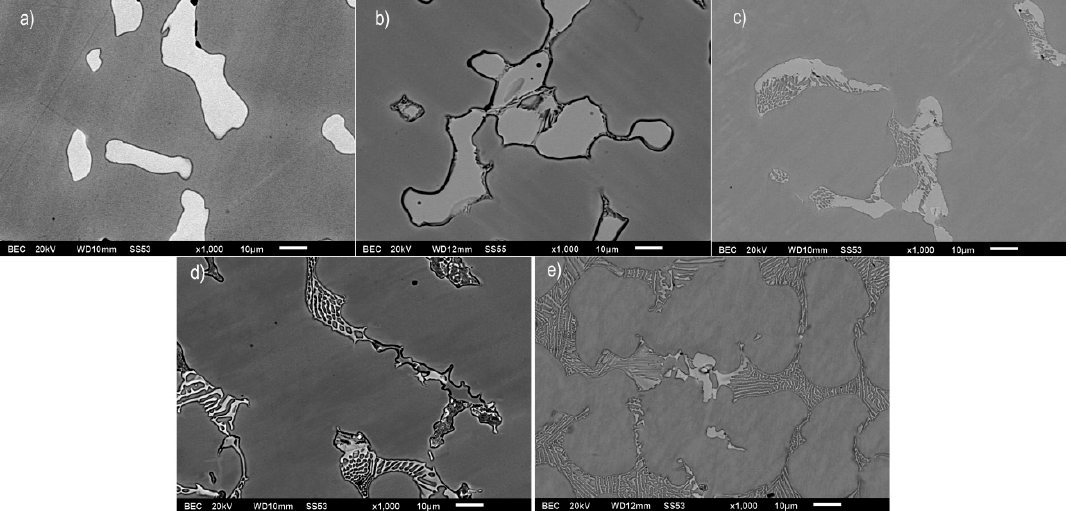
Figure 2. Microstructures in as-cast condition alloys; ( a ) 0B-AC, ( b ) 0.06B-AC, ( c ) 0.25B-AC, ( d ) 0.5B-AC and ( e ) 1B-AC.